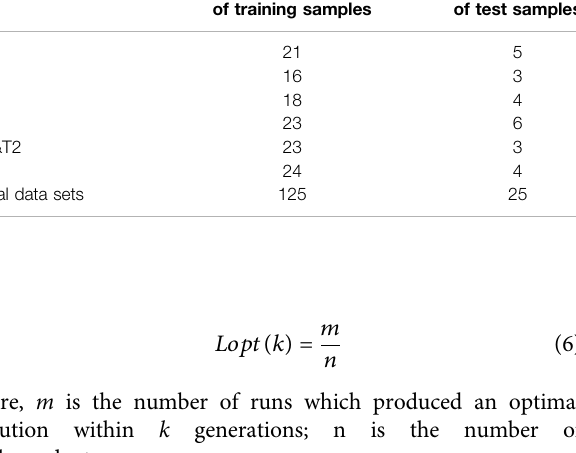
TABLE 2 | Numbers of DGA data used in the training and test process. Transformer states Number of training